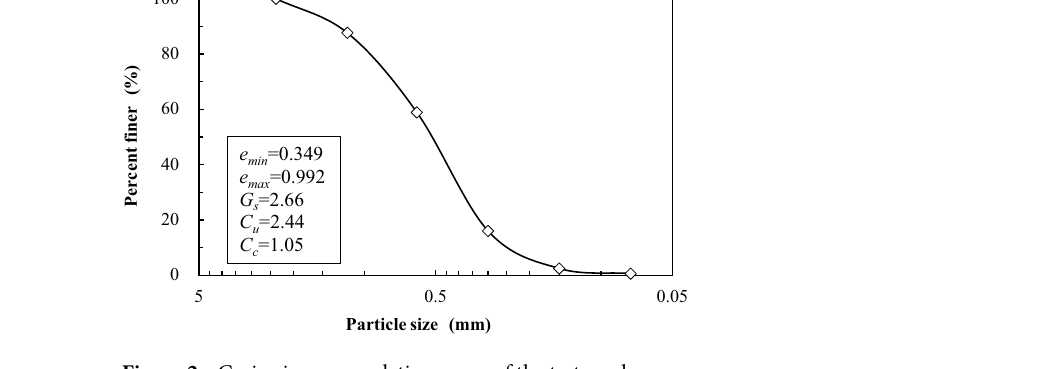
Figure 2. Grain size accumulation curve of the test